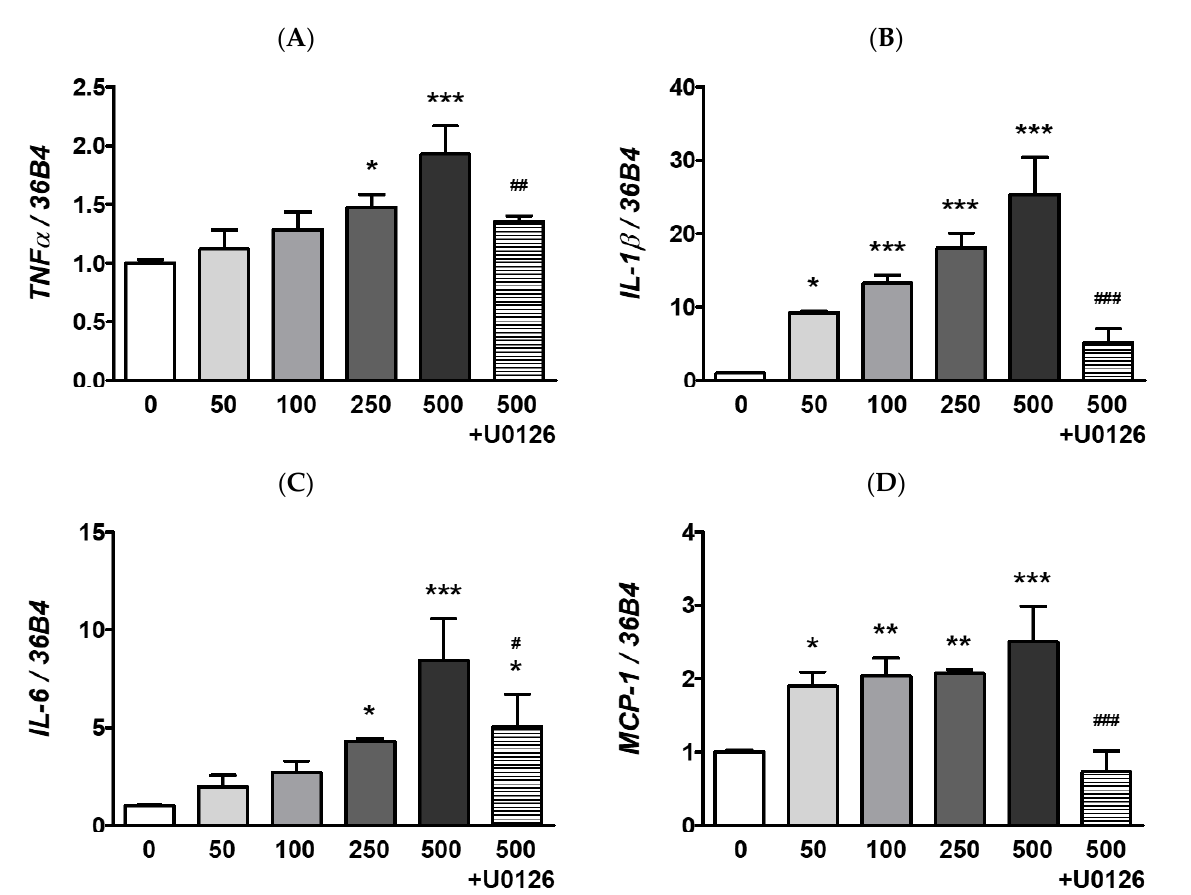
Figure 3. Effect of PM on inflammatory mRNAs expression in ARPE-19 cells. Cells were treated with 0–500 µ g/mL of PM for 2 h. The U0126 (20 µ M) was applied for 30 min before PM (500 µ g/mL) exposure. The mRNA levels of ( A ) TNF α , ( B ) IL-1 β , ( C ) IL-6 , ( D ) MCP-1 were measured by qRT-PCR, using 36B4 as the reference gene for normalization. Data are depicted as mean ± SD ( n = 3). Data were analyzed using one-way ANOVA followed by Tukey’s multiple comparison (* p < 0.05, ** p < 0.01, *** p < 0.001). Asterisk signs were used to indicate comparisons against the vehicle control group. Also, data were analyzed by student’s t -test and pound signs were used for comparisons between the 500 and 500+U0126 groups (# p < 0.05, ## p < 0.01, ### p < 0.001). PM; particulate matter, TNF α ; tumor necrosis factor alpha, IL-1 β ; interleukin-1 beta, IL-6; interleukin-6, MCP-1; monocyte chemoattractant protein-1